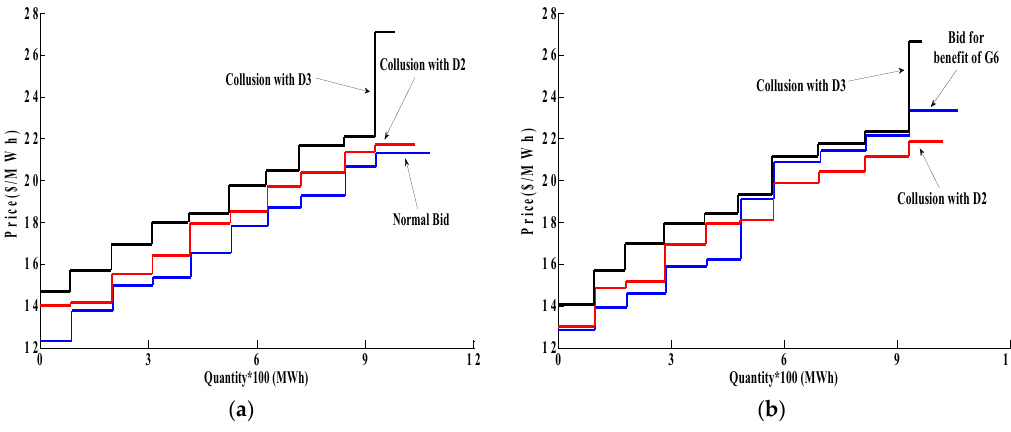
Figure 7. Bids of G1 as per Case B: ( a ) When D2 remains loyal; ( b ) when D2 does not remain loyal.